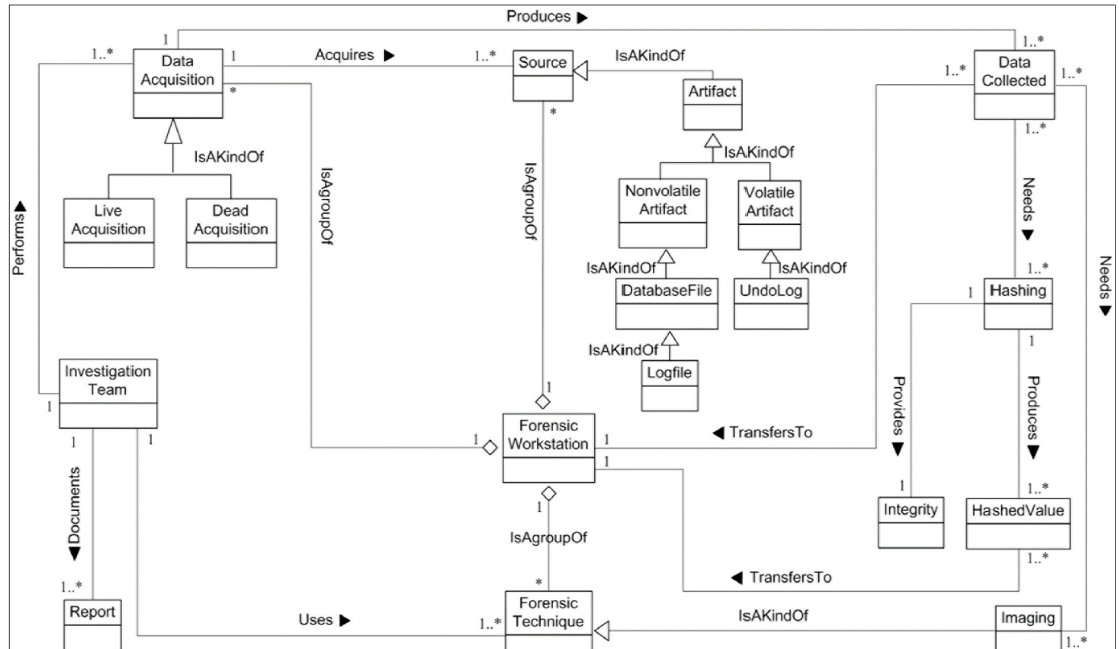
Figure 2. DBFIM artifact collection (Class 2).